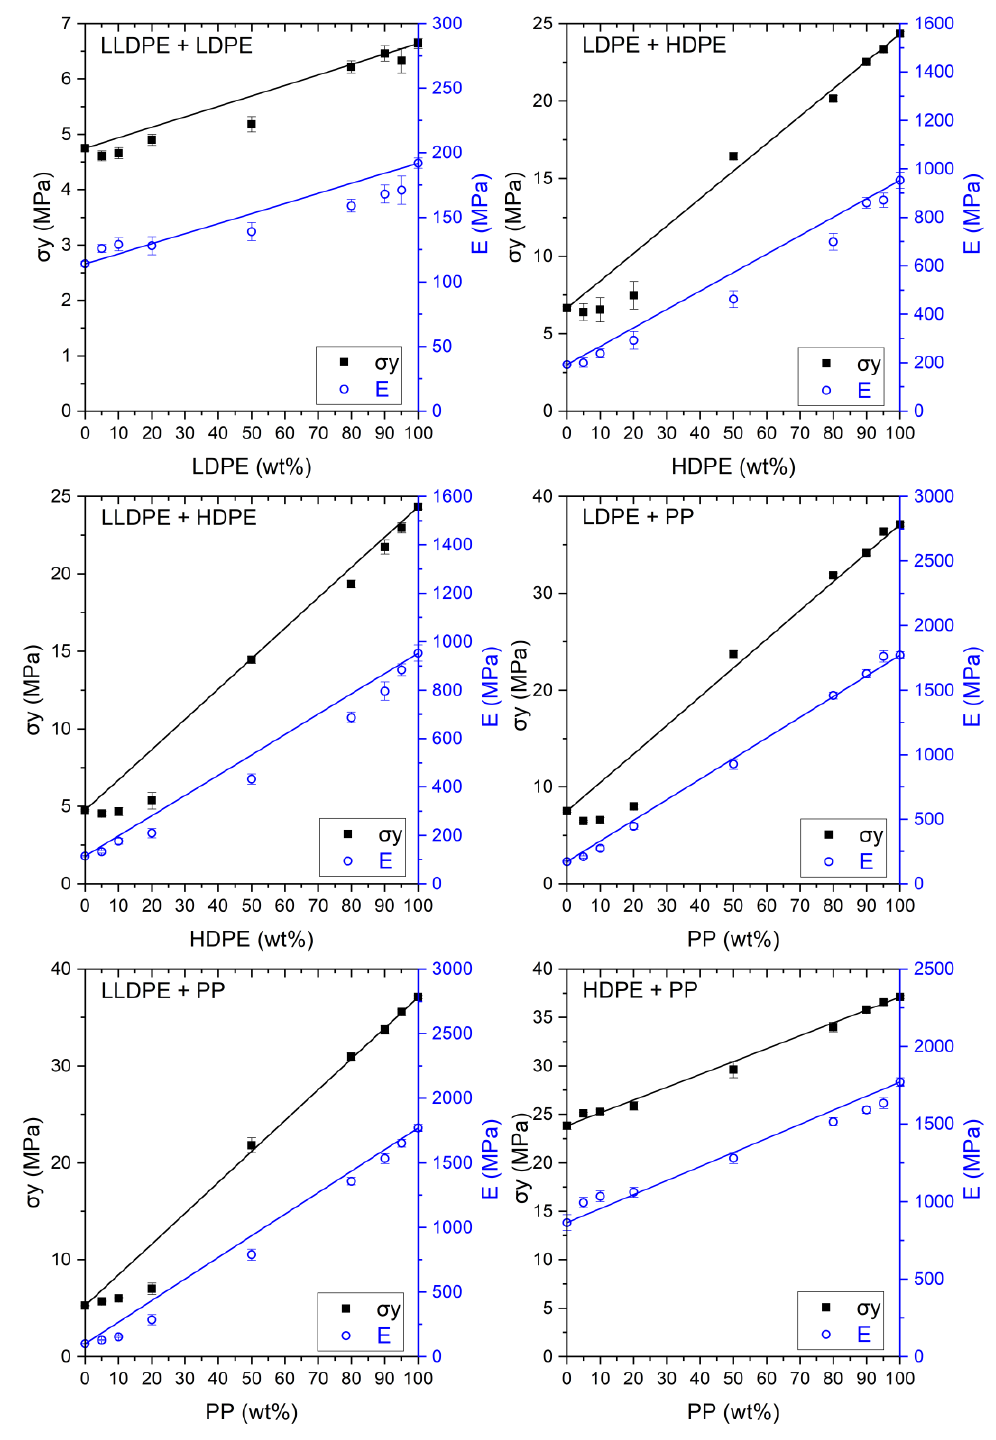
Figure 3. Overview of the σ y and E values for the investigated blends: LLDPE + LDPE; LDPE + HDPE; LLDPE + HDPE; LDPE + PP; LLDPE + PP; HDPE + PP. Lines give the prediction based on the rule of mixtures for σ y (black) and E (blue). Table 4. Stress–strain curves with a representative code, schematic dog bone deformation, mechanism, and typical materials. Test Bar Deformation Mechanism Code Curve Deformation Polymers/Blends